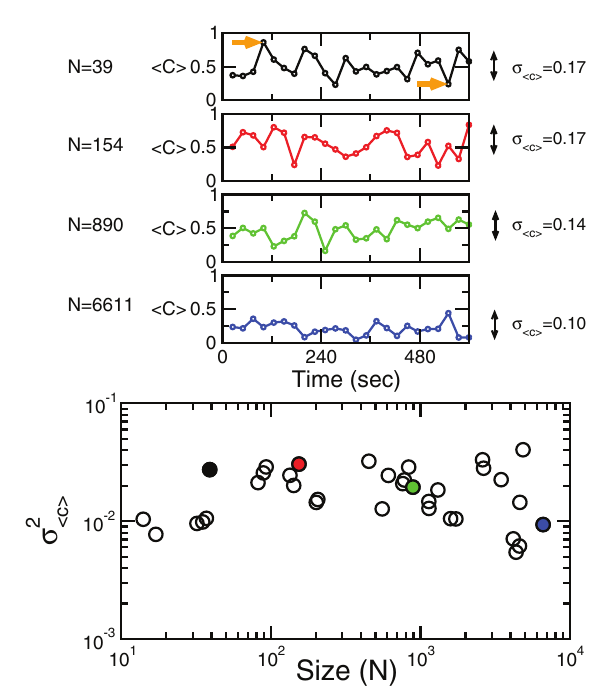
FIGURE 4 | Bursts of high correlations are observed at all cluster sizes, resulting in approximately the same variance, despite the four orders of magnitude change in the cluster size. The top panels illustrate representative examples of short-term mean correlation (cid:3) C (cid:4) of the BOLD signals as a function of time for four sizes spanning four orders of magnitude. The arrows show examples of two instances of highly correlated and weakly correlated activity, respectively. Bottom panel shows the variance of (cid:3) C (cid:4) as a function of cluster sizes. The four examples on the top traces are denoted with filled circles in the bottom